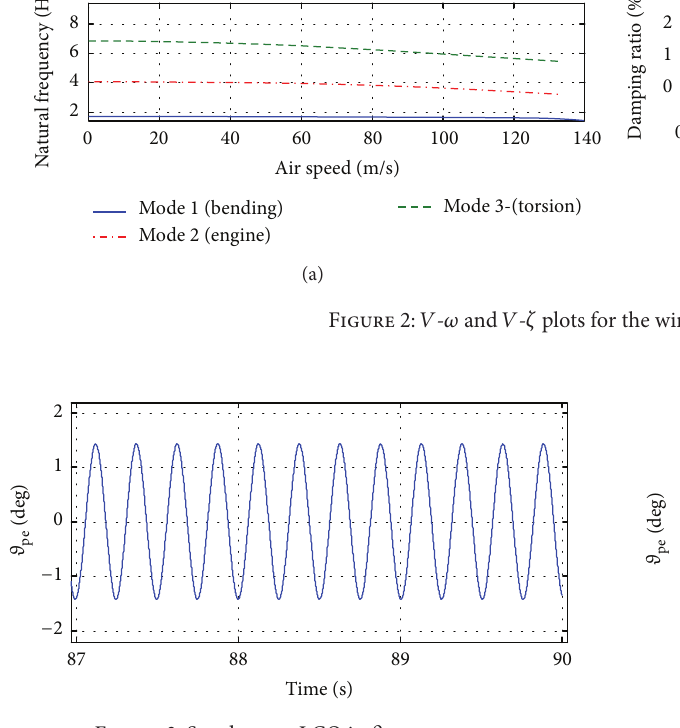
Figure 4: Decaying response, just below linear flutter